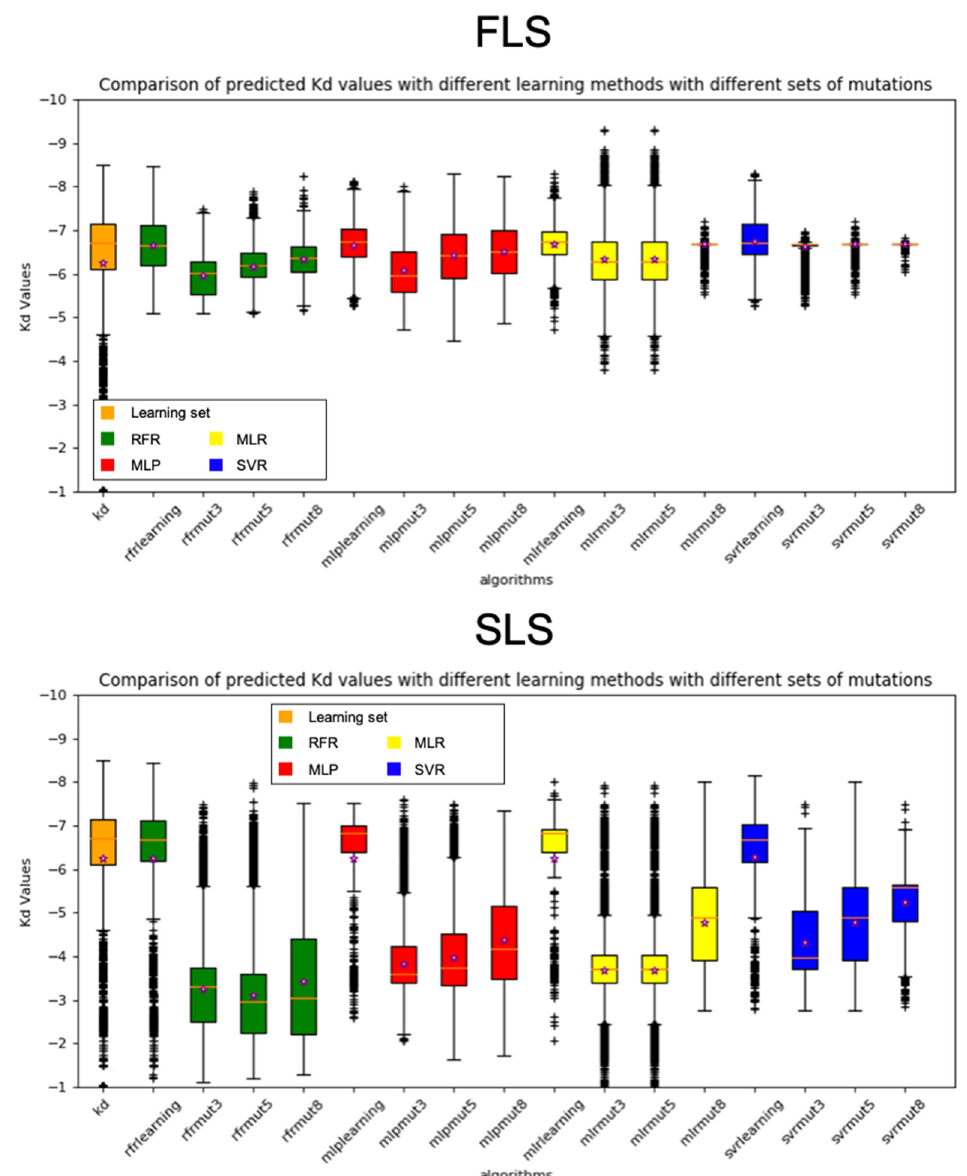
Figure 2. K D distributions obtained with the four different algorithms in the two models for the three sets of random mutants. RFR in green, MLP in red, MLR in yellow, SVR in blue, trained either with FLS ( top ) or SLS ( bottom ) models. Purple star represents the average K D .